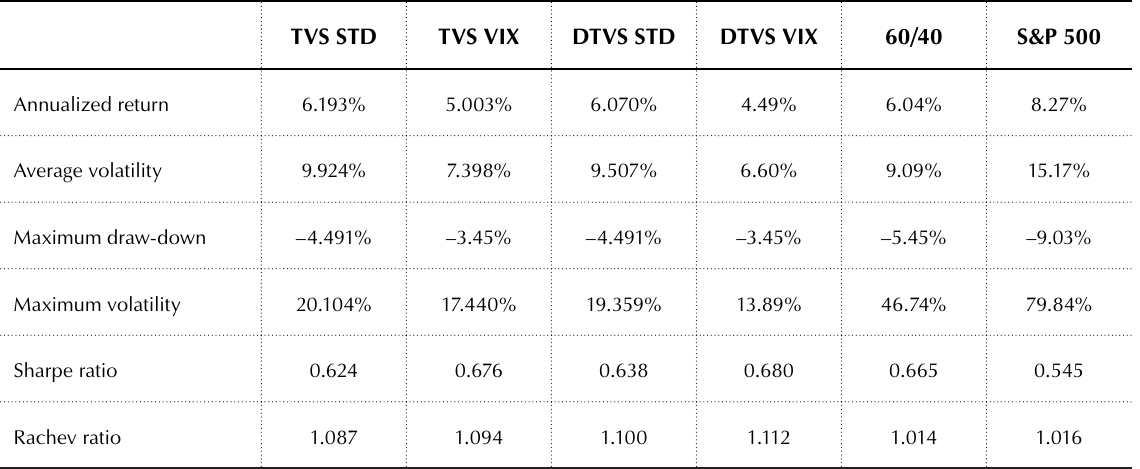
Table 1. Portfolio statistics for constant frequency rebalancing